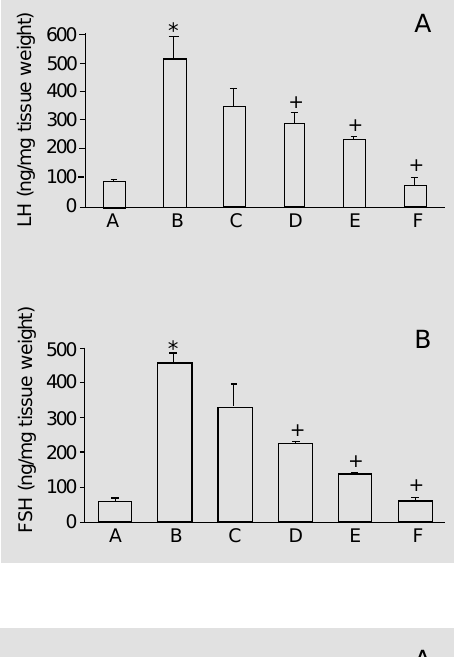
Figure 5 - Effects of administra- tion of 0.01 µM adenosine on LH (A) and FSH (B) secretion in- hibited by 5 mM LiCl. The prepa- ration conditions are the same as described in the legend to Figure 1. A = Basal, B = 10 nM adenosine, C = 5 mM LiCl + 10 nM adenosine, D = 5 mM LiCl, E = 5 mM LiCl + 1 mM myo-inositol, F = 1 mM myo- inositol. Data are reported as means ± SEM (N = 5). *P<0.05 compared to control (A) (Newman-Keuls test).